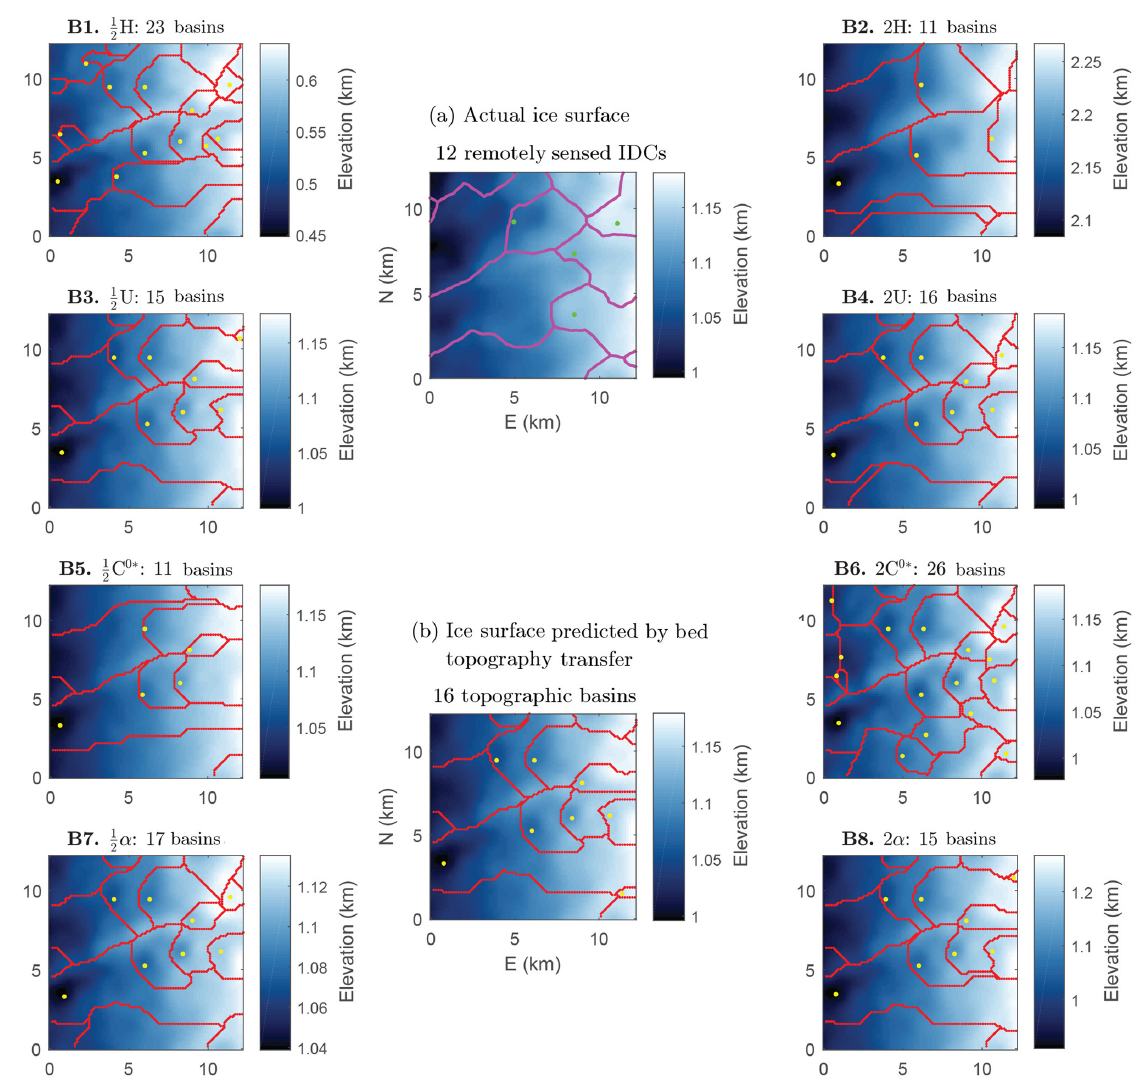
Figure 11. (a) IDCs (magenta outlines) and moulins (green dots) obtained from satellite images by Yang and Smith (2016). (b, B1–B8) Ice surface topographic basins (red outlines) and local minima (yellow dots) on ice surfaces predicted with bed topography transfer with various ice flow parameters. Study region R1 (Fig. 1a, Table 1) with η = 10 14 Pas and baseline C 0 ∗ = 10. While the bed-transfer-predicted topo- graphic basin configuration in (b) is different from the IDC configuration in (a) , the basin densities are similar. Changing ice thickness H or basal sliding parameter C 0 ∗ by a factor of 2 produces significant changes in predicted topographic basin configurations ( B1, B2 and B5, B6